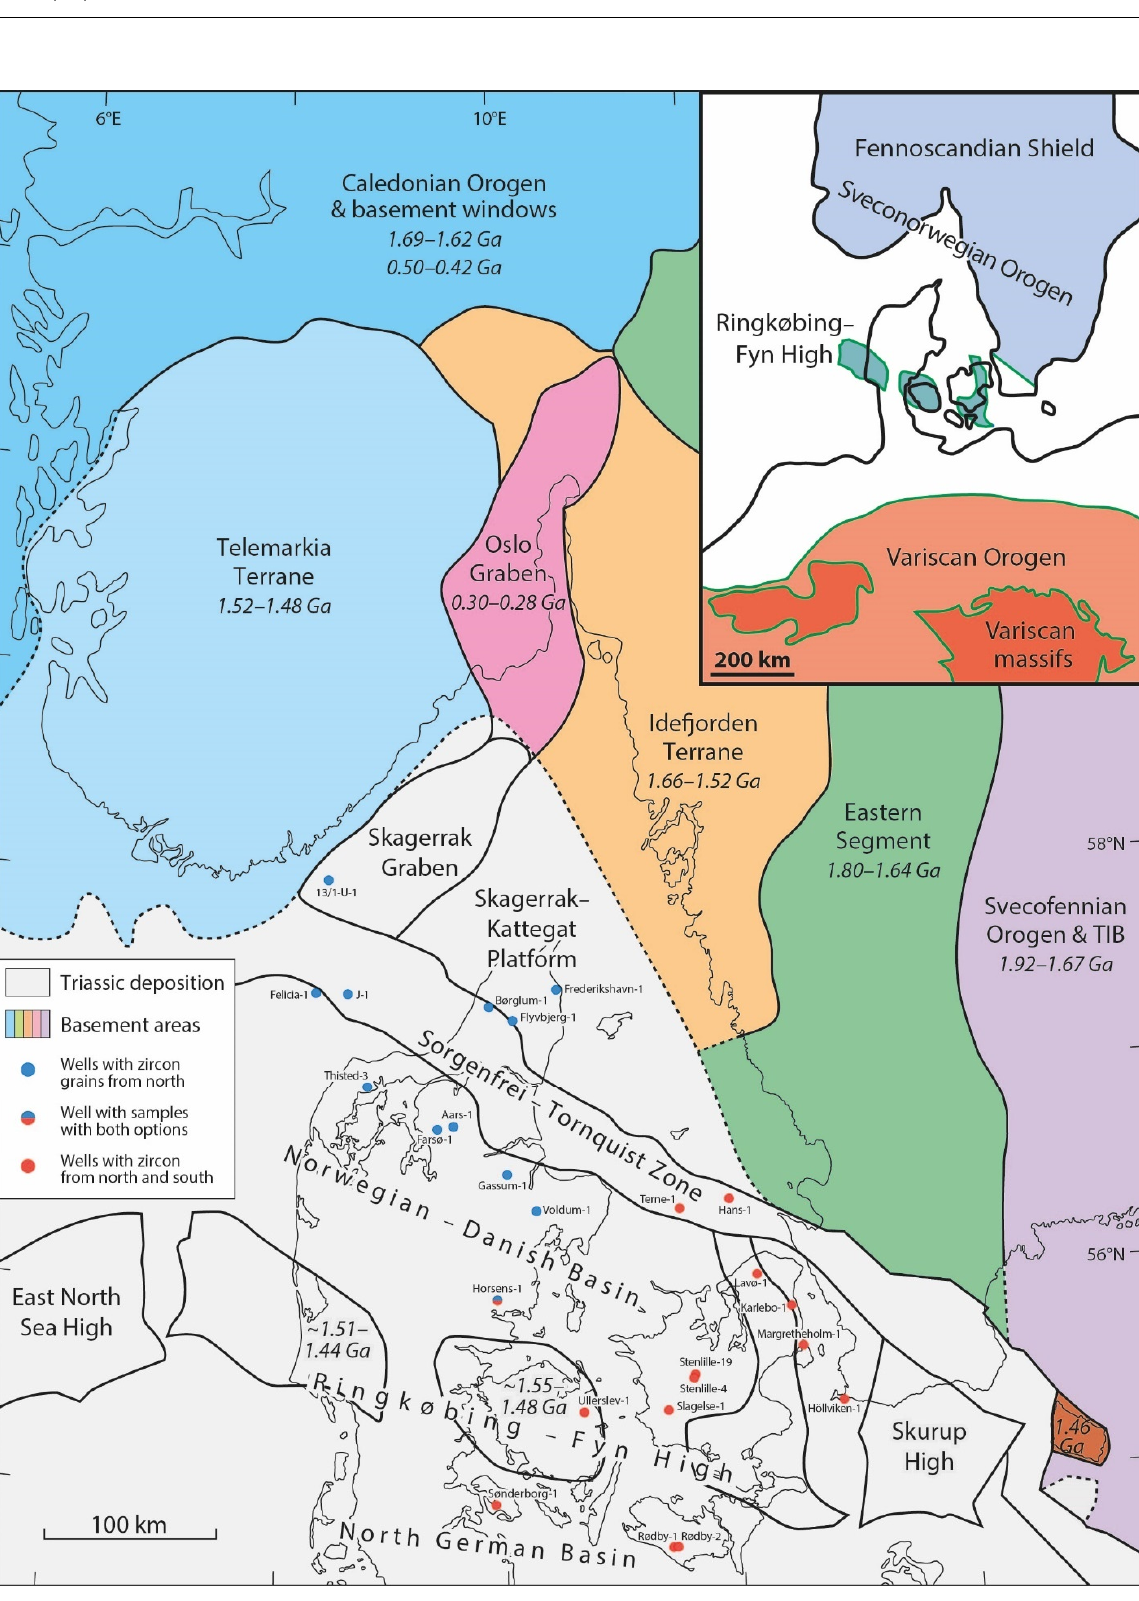
Figure 2. Map of the basement provinces in the southern part of the Fennoscandian Shield with indications of their magmatic zircon ages. The location of the Variscan Orogen is outlined on the overview map. The wells show where zircon U-Pb analyses of the Gassum Formation were made. TIB: Transscandinavian Igneous Belt. The area of Triassic deposition is based on [13,33,34]. The structural elements are from [24,28,30,35,36]. The ages in billion years (Ga) are from [28,37–39].